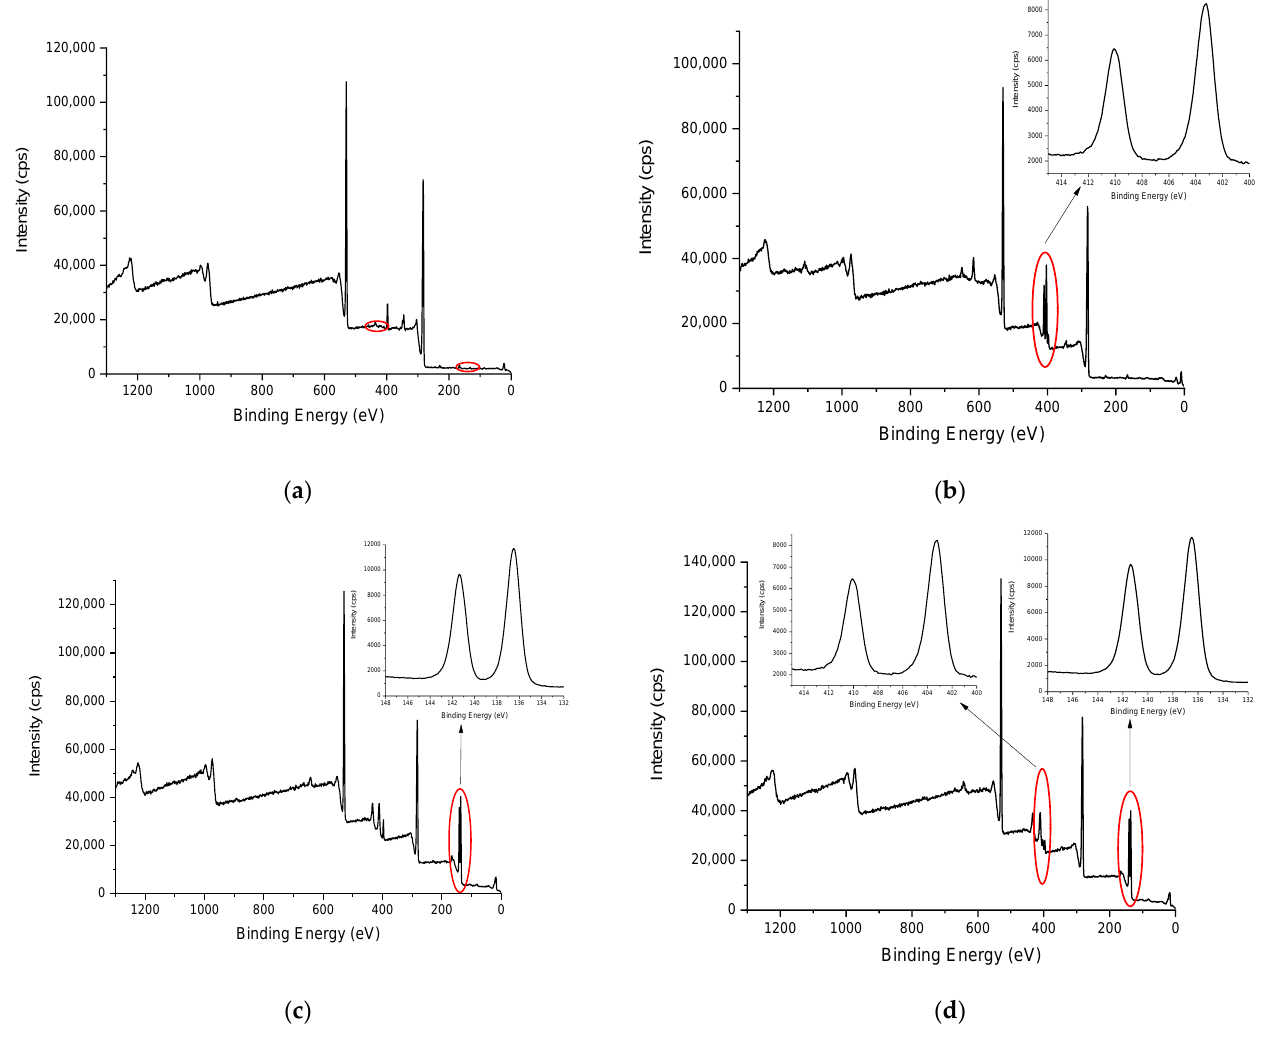
Figure 8. XPS spectra of ( a ) Sargassum biomass, ( b ) Sargassum biomass after Cd adsorption, ( c ) Sargassum biomass after Pb adsorption, and ( d ) Sargassum biomass after competitive Cd and Pb adsorption. In Figure 8a, a peak can be observed in the region close to 349 eV, which corresponds to the 2p calcium line. However, when the material is subjected to the adsorption process and replaced by the adsorbed